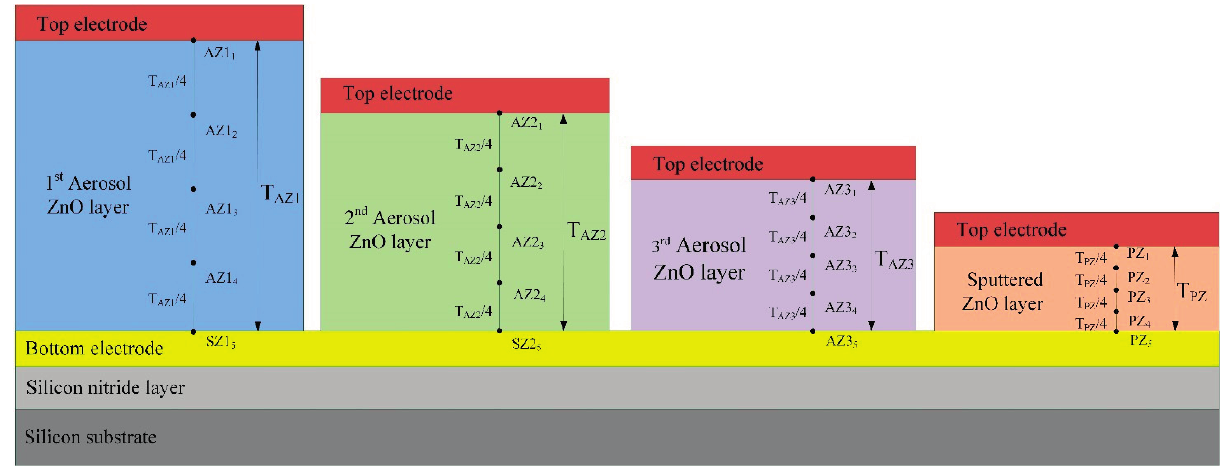
Figure 7. Points defined for explaining the transient temperature fields in the meliorated multi-frequency band pyroelectric